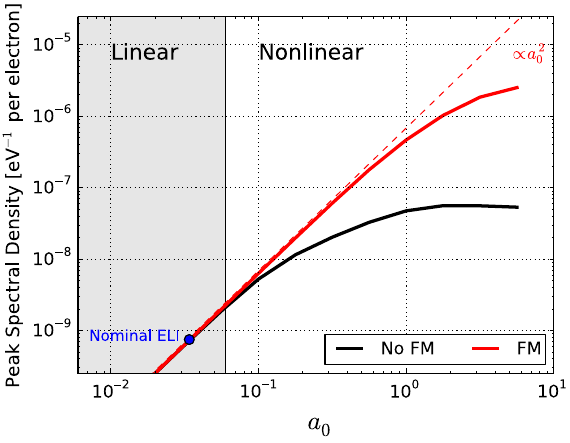
FIG. 6. Peak spectral density for ELI-NP parameters as the field strength parameter a 0 is varied. Black line denote non-FM spectra and red lines denote FM. Nominal ELI-NP parameters ( a 0 ¼ 0 . 036 ) is shown as a blue